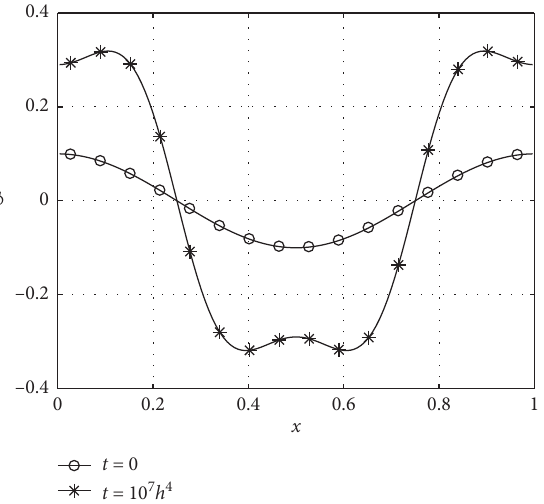
Figure 3: Initial condition and the reference numerical solution at t � 10 7 h 4